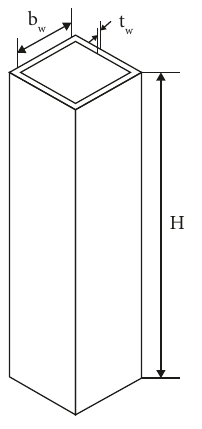
Figure 2: Schematic diagram of the sample’s size.